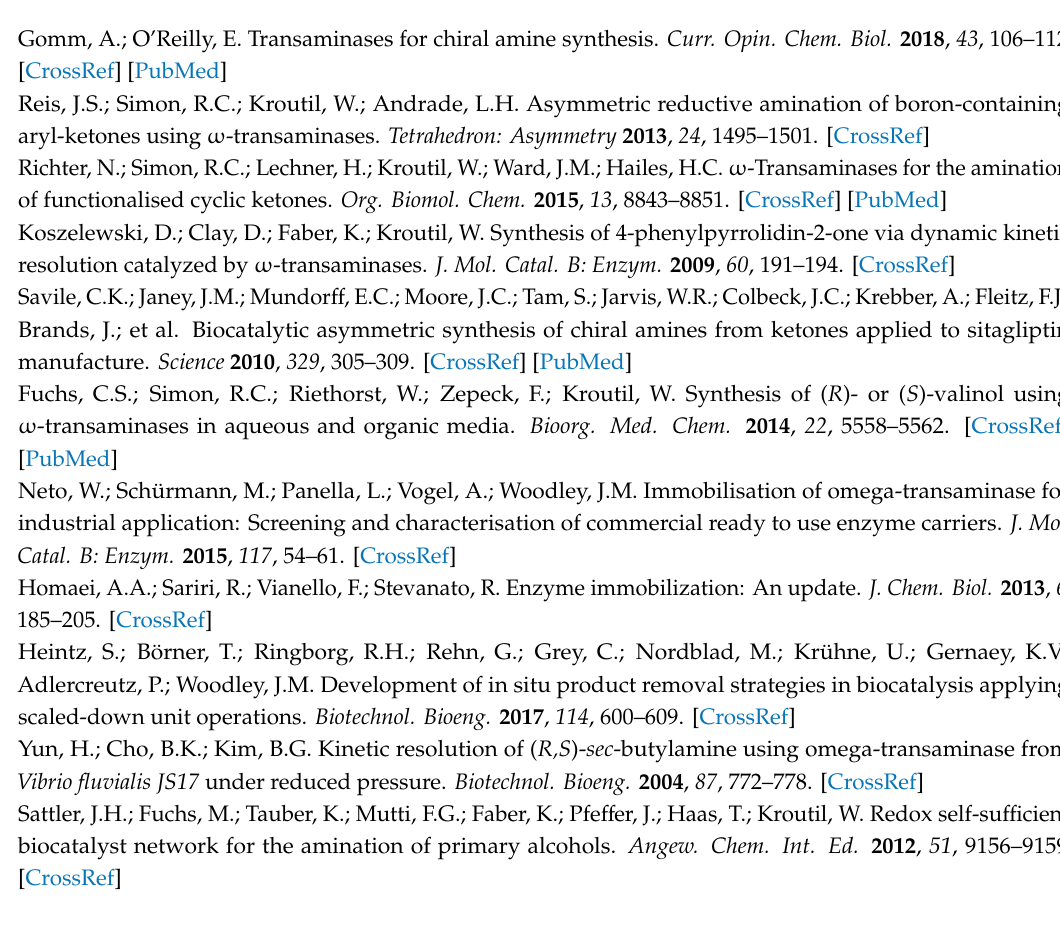
Figure S1: 1 H-NMR spectrum of rac - 1d , Figure S2: 13 C-NMR spectrum of rac - 1d , Figure S3: FT-IR spectrum of rac - 1d , Figure S4: GC chromatogram of rac - 1a and 2a , Figure S5: GC chromatogram of rac - 1b and 2b , Figure S6: GC chromatogram of rac - 1c and 2c , Figure S7: GC chromatogram of rac - 1d and 2d , Figure S8: GC chromatogram of KR from rac - 1d , Figure S9: GC chromatogram of (R) - 1d after working up the KR reaction mixture, Figure S10: 1 H-NMR spectrum of (R)- 1d , Figure S11: 13 C-NMR spectrum of (R) - 1d , Figure S12: FT-IR spectrum of (R) - 1d ., Figure S13: GC chromatogram of KR from rac - 1d , Figure S14: GC chromatogram of (S) - 1d after working up the KR reaction mixture, Figure S15: 1 H-NMR spectrum of (R) - 1d , Figure S16: 13 C-NMR spectrum of (R) - 1d , Figure S17: FT-IR spectrum of (S) - 1d , Figure S18: pH dependence of the transaminase containing wet E. coli cells and the immobilized TA biocatalysts, Table S1: GC data of reference substrates and